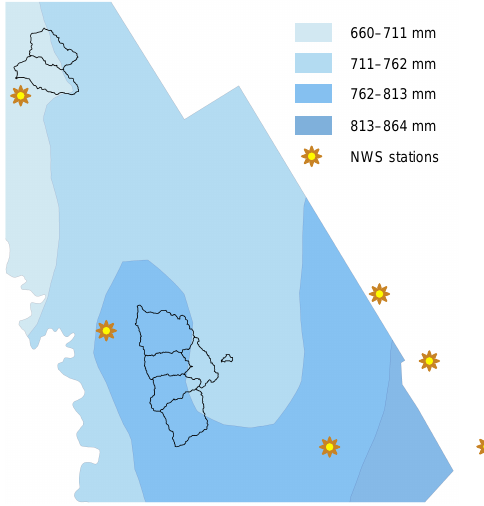
Figure 2. Average annual precipitation gradient and location of Na- tional Weather Service (NWS) stations used to construct historical precipitation